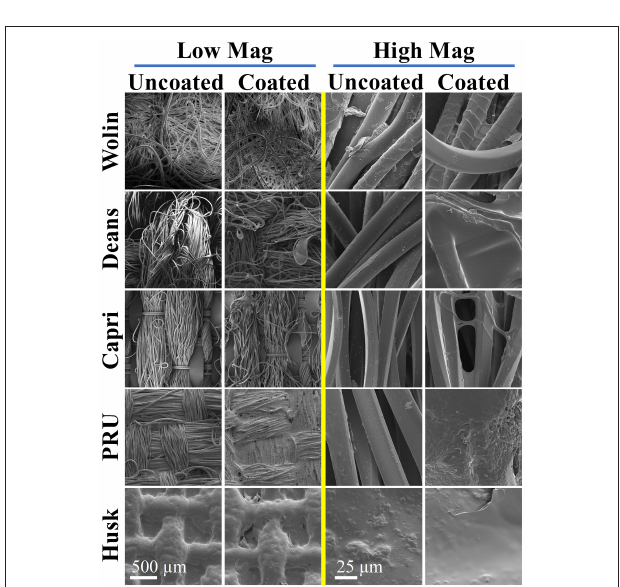
FIGURE 4 | SEM images of uncoated and coated (SbQ-PVA/ZnTMPyP 4 + ) Vescom materials at low (left) and high (right) magnifications.